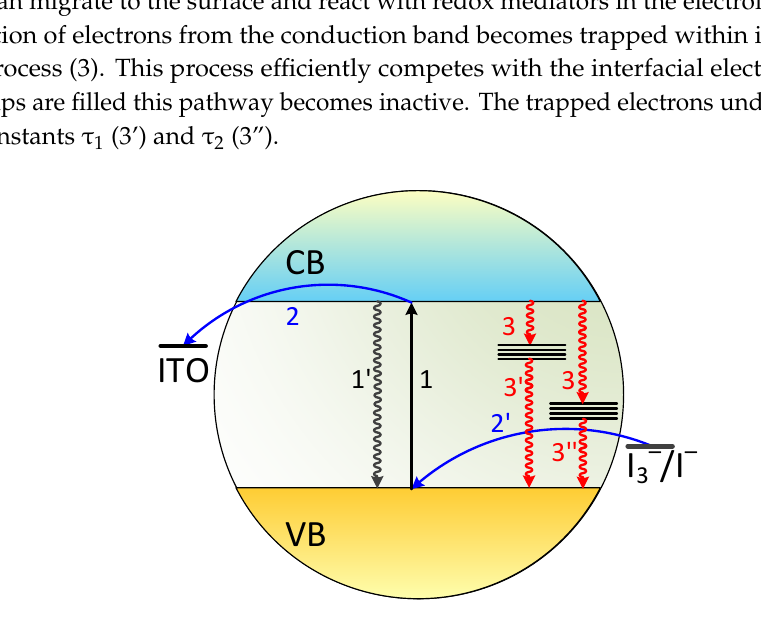
Figure 4. A tentative mechanism of the photocurrent generation and charge carriers trapping in the nanocrystalline CdS sample under consideration.